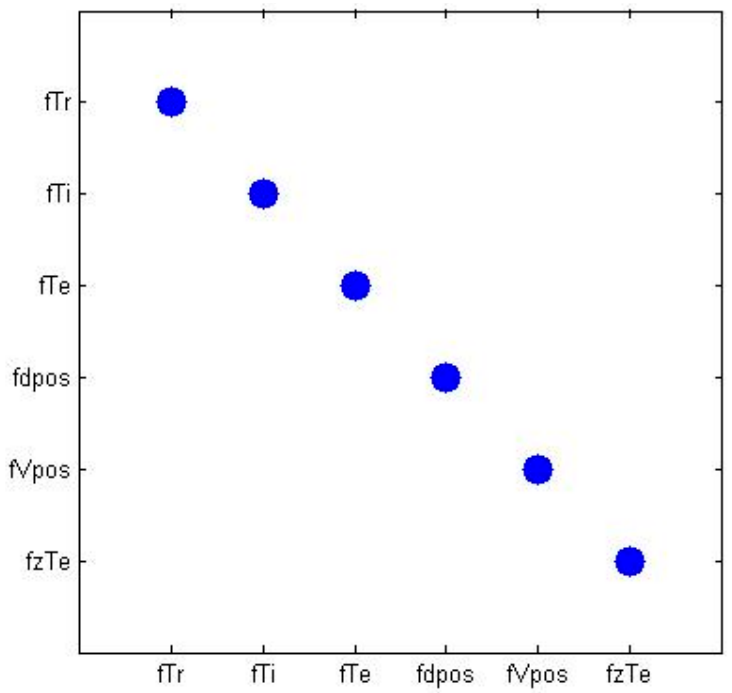
Figure 6. New added sensor Te has become faulty and fault fzTr has been added to the isolability matrix.